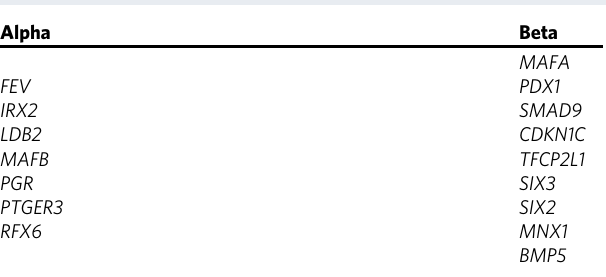
Table 2 Speci fi c cell-type TF